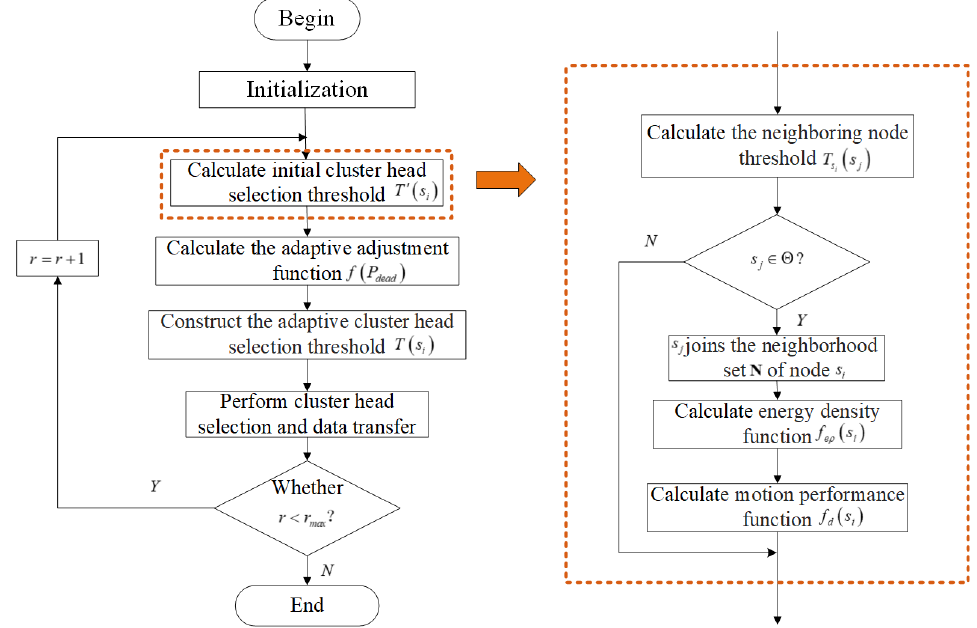
Figure 9. Cluster-Based Energy Optimization with Mobile Sink (CEOMS) algorithm flow